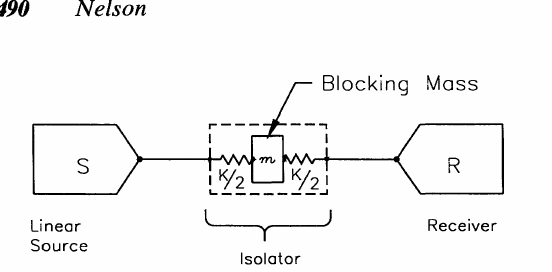
FIGURE 10 Schematic of a linear source (S) driving a piece of equipment (R) through an isolator contain ing a blocking mass (m).